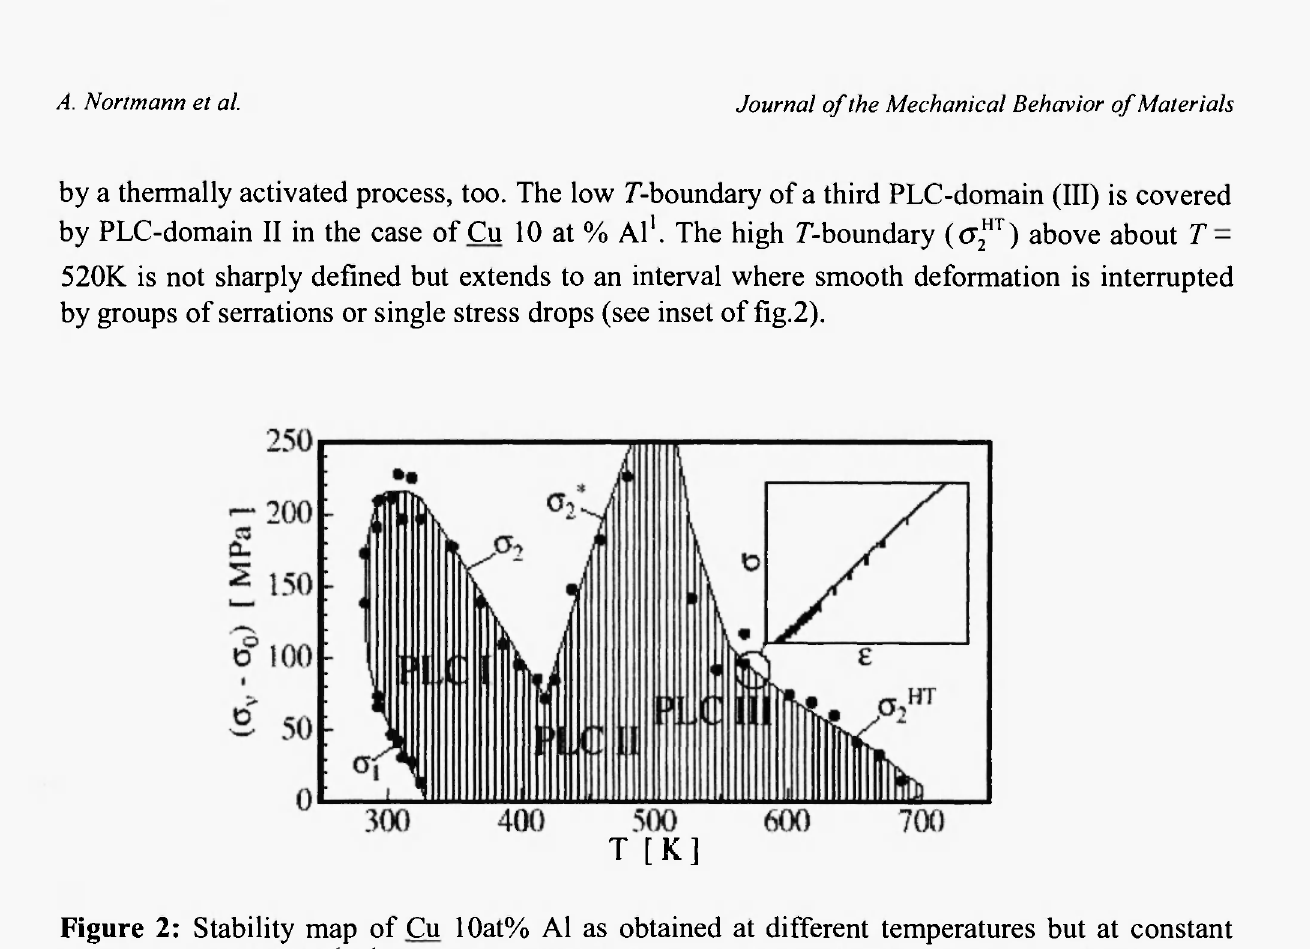
Figure 2: Stability map of Cu 10at% Al as obtained at different temperatures but at constant strain rate έ = 2.5 10" 6 s" 1 . The reduced critical stresses (σ -σο) indicate the transition between ν stable and unstable deformation (o(e)-curves running parallel to the ordinate). The hatched areas indicate the PLC regions. The high T-boundary σ 2ΗΤ is not sharply